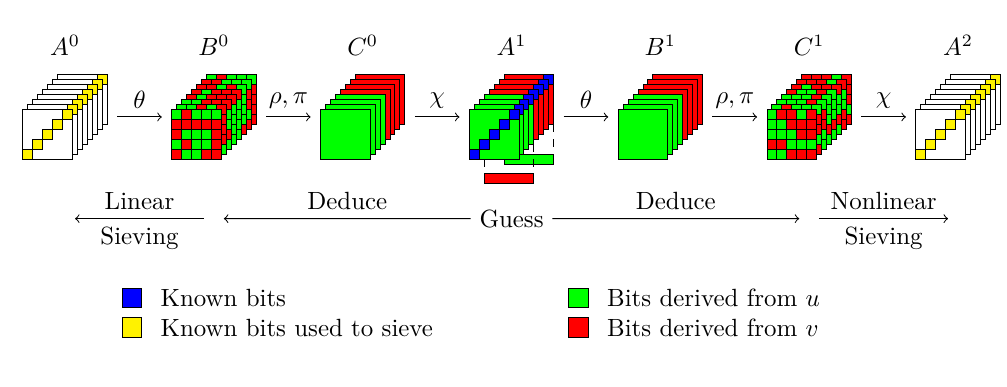
Figure 5: Summary of our advanced divide-and-conquer